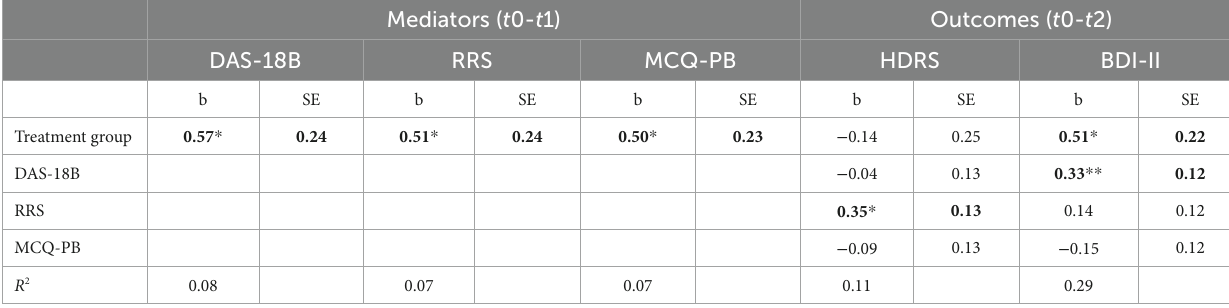
TABLE 3 Direct effects of treatments on mediators and of mediators on clinician-rated and self-reported depression.